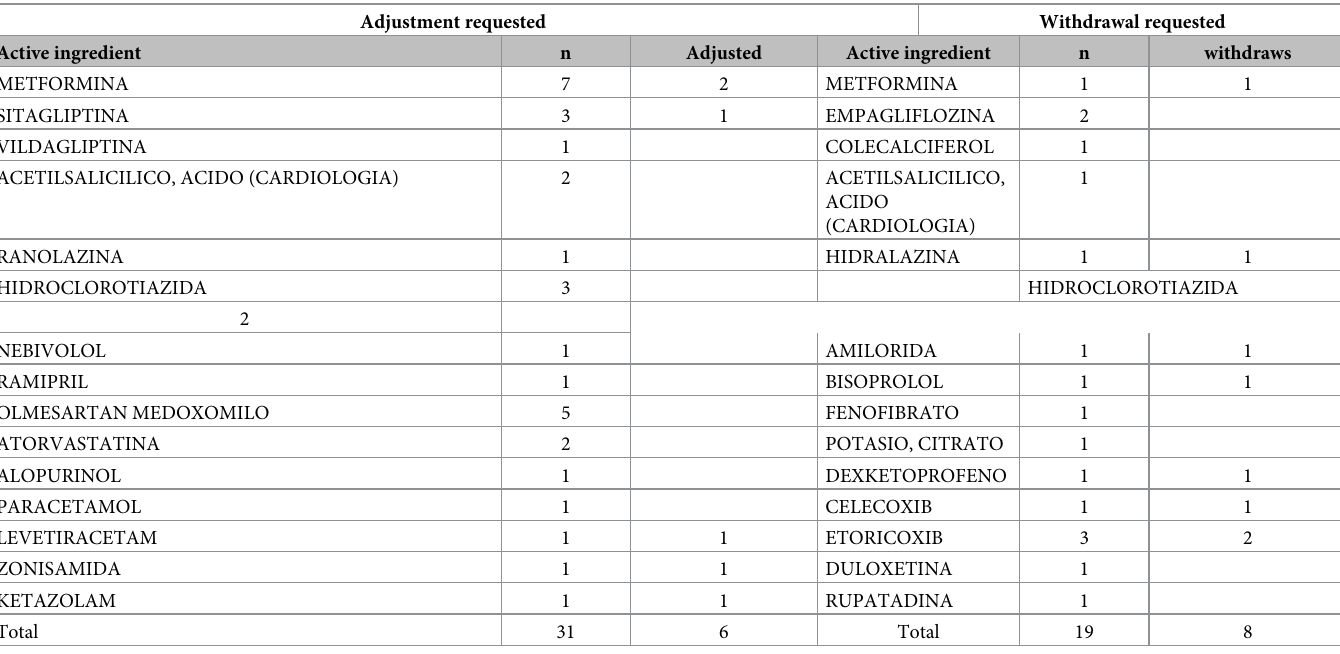
Table 4. Medicines for which a change is requested and the outcome of the request.